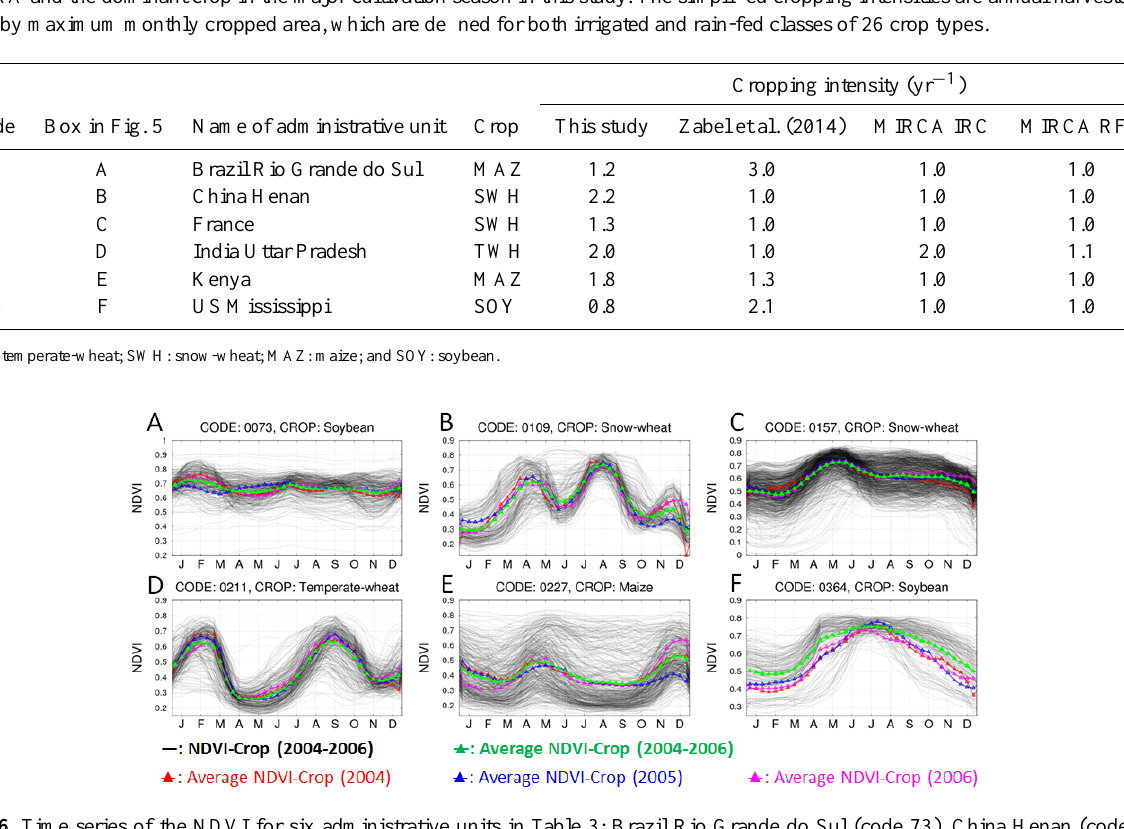
Figure 6. Time series of the NDVI for six administrative units in Table 3; Brazil Rio Grande do Sul (code 73), China Henan (code 109), France (code 157), India Uttar Pradesh (code 211), Kenya (code 227), and US Mississippi (code 364). Black lines show time series of NDVI-Crop averaged over 2004–2006 in the administrative units (i.e., the NDVI of all grids in the administrative units). Green lines show the average of black lines (i.e., averaged over the administrative units). Red, blue, and magenta represent NDVI-Crop in 2004, 2005, and 2006, respectively, averaged over the administrative